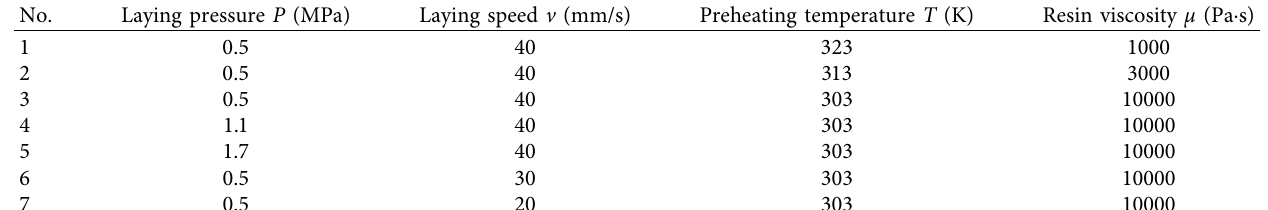
Table 2: The single-factor simulation parameters.